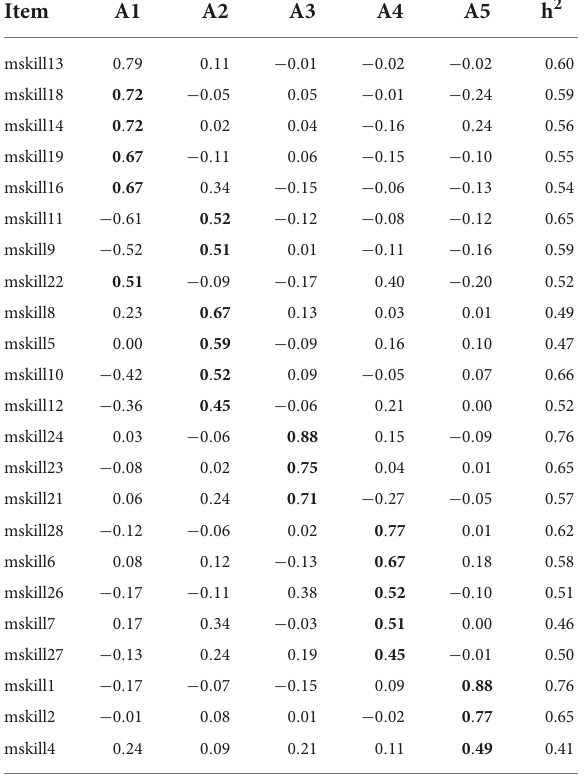
TABLE 3 Pattern (A) matrix and communalities